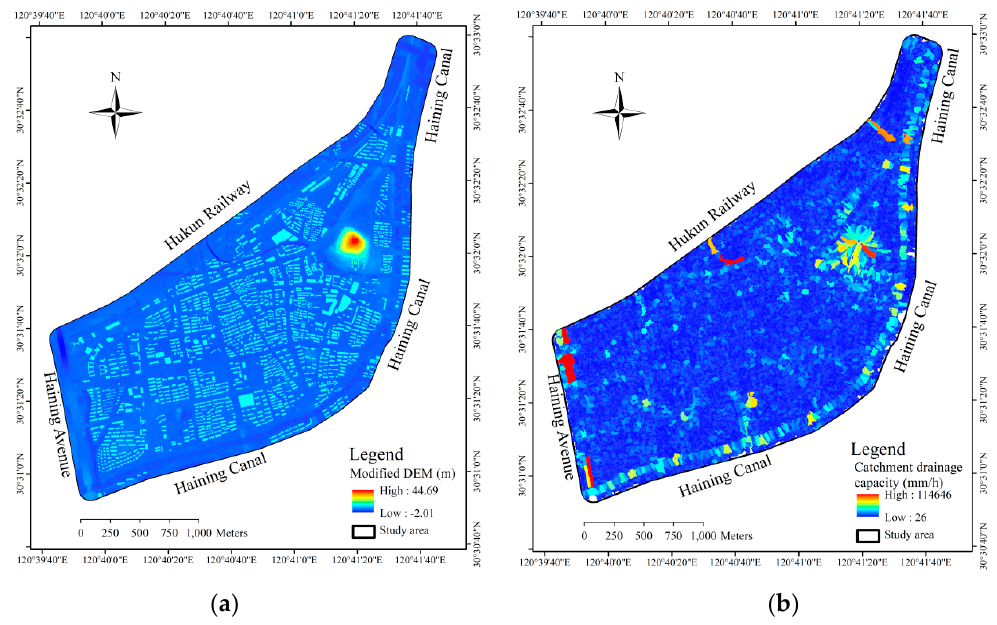
Figure 7. Urban terrain and catchment modification results. ( a ) urban terrain modification results; ( b ) catchments and their drainage capacities.